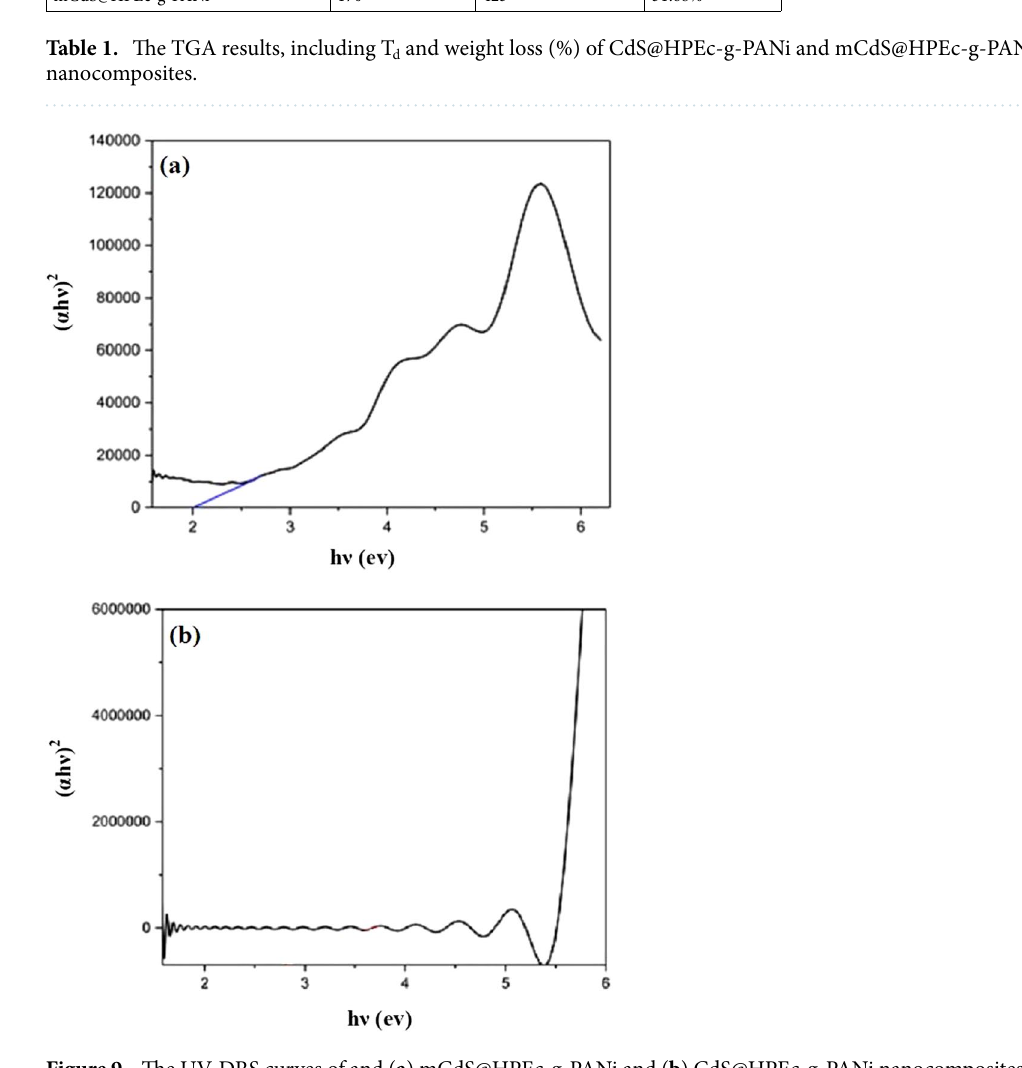
Figure 9. The UV-DRS curves of and ( a ) mCdS@HPEc-g-PANi and ( b ) CdS@HPEc-g-PANi